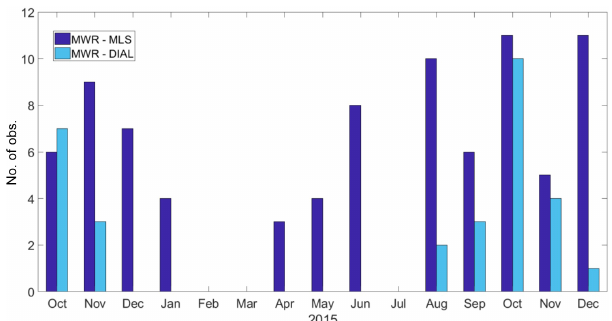
Figure 4. Number of inter-compared measurement pairs for each month. Blue bars represent the number of MWR–MLS pairs, while light blue bars are the number of MWR–DIAL